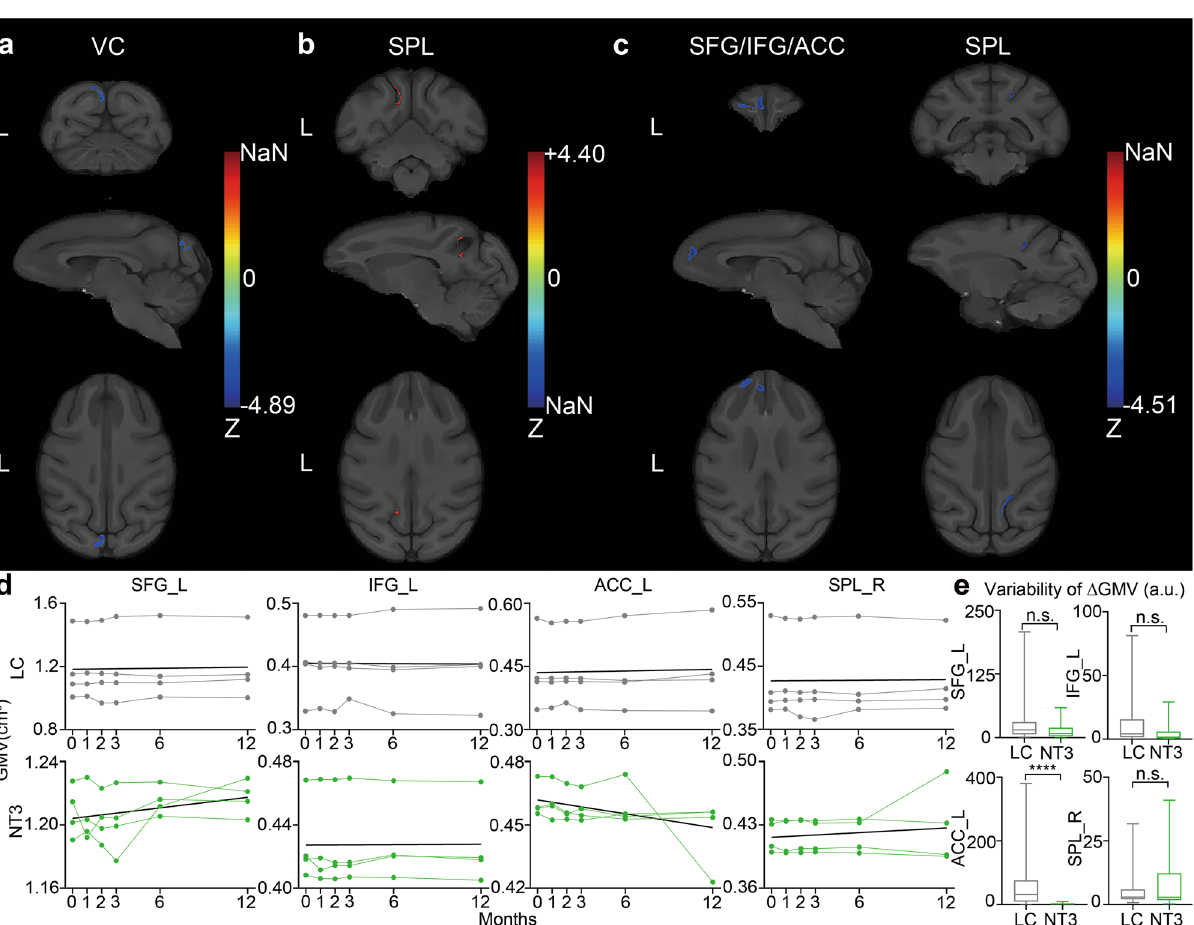
Figure 2. Longitudinal GMV alterations of LC and NT3 animals over 1 year after injury. ( a ) The brain regions in which the GMV of the LC significantly decreased over time within 1 year. ( b ) The brain regions in which the GMV of the NT3 group significantly increased over time within 1 year. ( c ) The brain regions in which the GMV alteration showed significant differences between the two groups. Only clusters with significant differences were displayed. One-sample t test was used for intra-group modeling, and two-sample t test was used for inter-group comparison, with GRF correction. The voxel level was set to p < 0.005, and the cluster level was set to p < 0.05. The brain regions where the significant clusters were located are presented above the images. A positive value in the Z-bar indicated that LC > NT3; L indicated the left side. d) The results of longitudinal alterations in GMV in the significantly different brain regions. e) The results of inter-group comparisons on the variability of GMV alteration rate in the significantly different brain regions (two-sample K-S Z test). ****p < 0.0001; VC visual cortex, SPL superior parietal lobule, SFG superior frontal gyrus, IFG inferior frontal gyrus, ACC anterior cingulate cortex, LC lesion control, NT3 neurotrophin-3, GMV gray matter